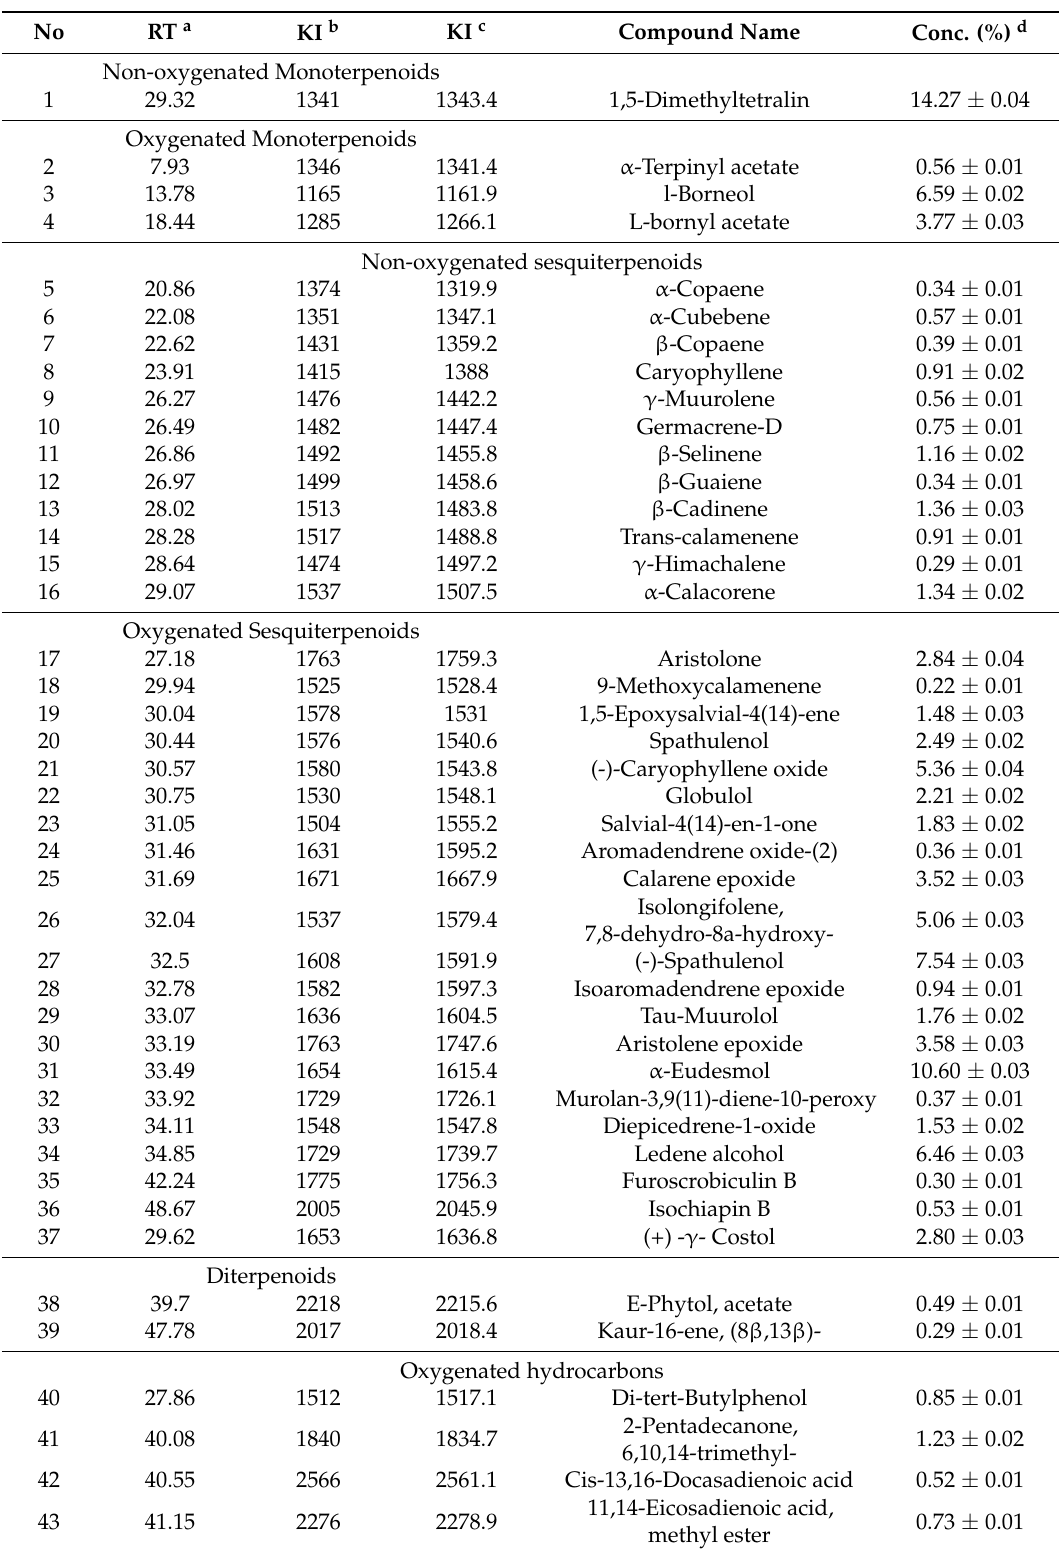
Table 1. Chemical composition of the EO of X. strumarium leaves collected from Egypt analyzed by